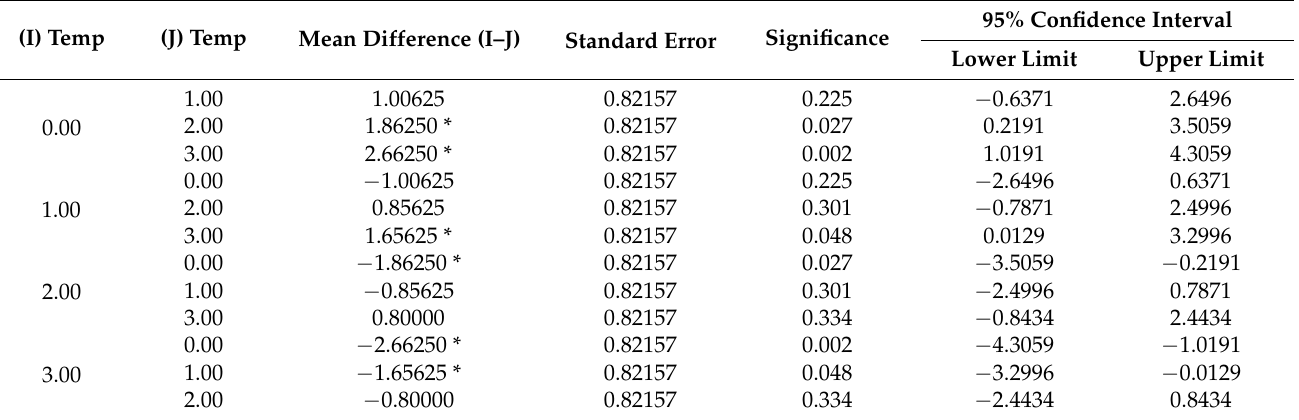
Table 4. Multiple comparisons